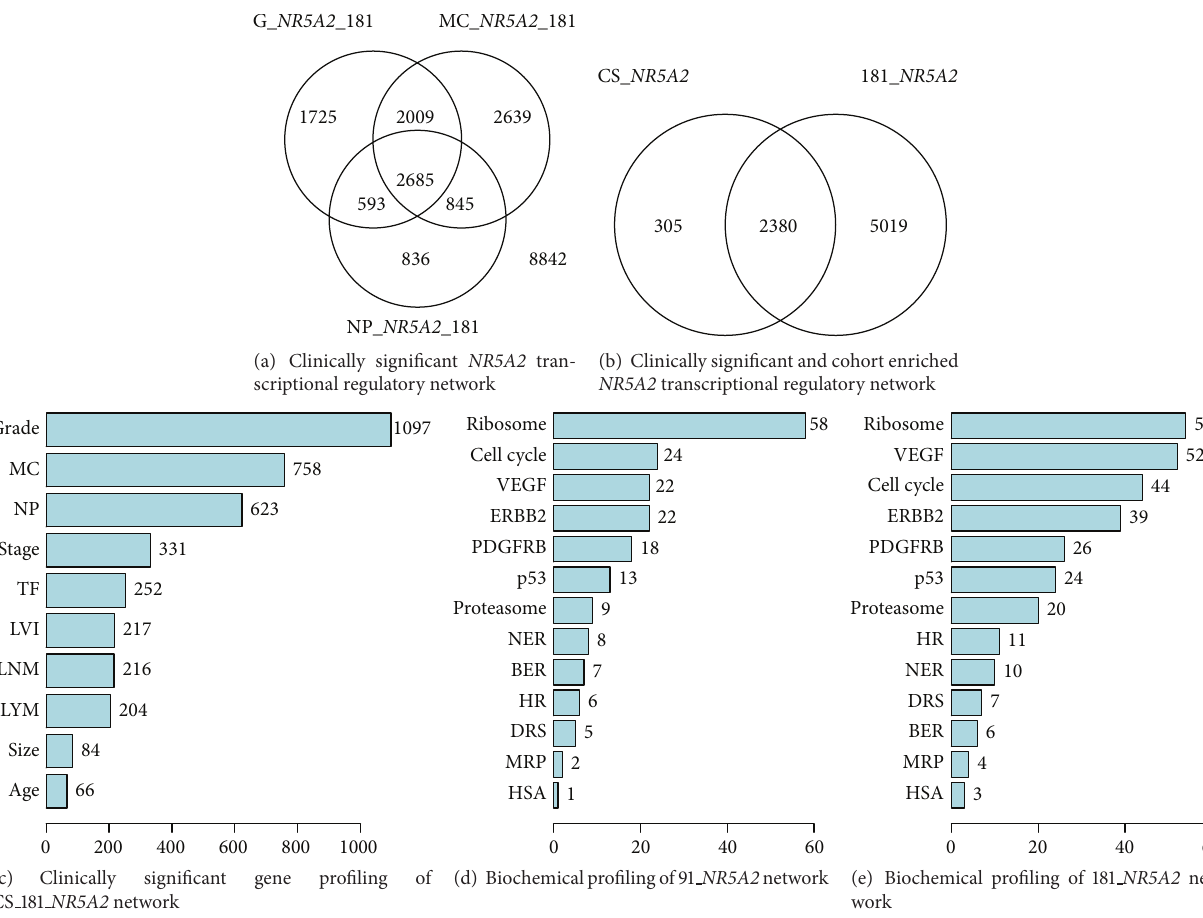
Figure 3: Clinical and/or cohort significance of transcriptional activities of NR5A2 in given population(s). (a) Clinically significant (CS) NR5A2 transcriptional regulatory network (CS NR5A2 network). (b) Clinically significant and cohort enriched NR5A2 transcriptional regulatory network ( CS 181 NR5A2 network). (c) The bar chart for overlapping gene pools ( 𝑥 -axis) between the CS 181 NR5A2 network and clinical relevant genes in 10 clinical parameters ( 𝑦 -axis). (d) The bar chart for overlapping gene pools ( 𝑥 -axis) between 91 NR5A2 network and genes in 13 signal transduction pathways ( 𝑦 -axis). (e) The bar chart for overlapping gene pools ( 𝑥 -axis) between the 181 NR5A2 network and genes in 13 signal transduction pathways ( 𝑦 -axis). The signal transduction pathways are derived from Kyoto Encyclopedia of Genes and Genomes (KEGG) database and National Center for Biotechnology Information (NCBI) pathway interaction